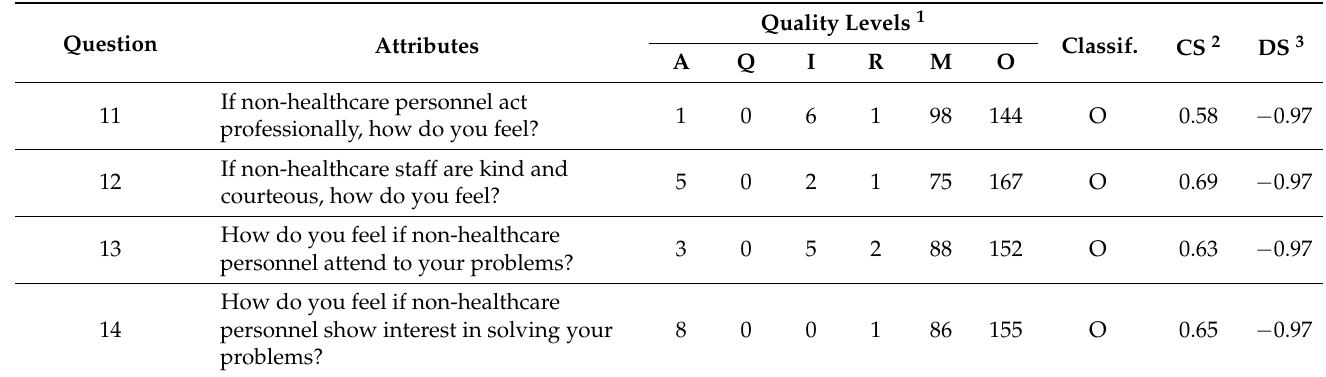
Table 5. Results corresponding to the non-healthcare personnel dimension.